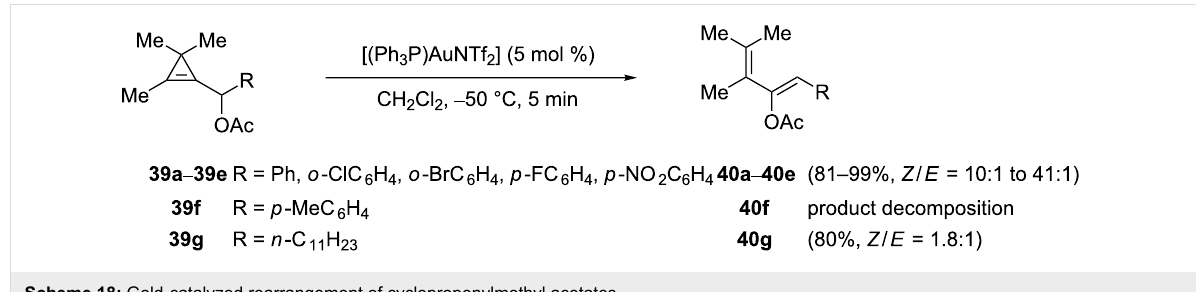
Scheme 18: Gold-catalyzed rearrangement of cyclopropenylmethyl